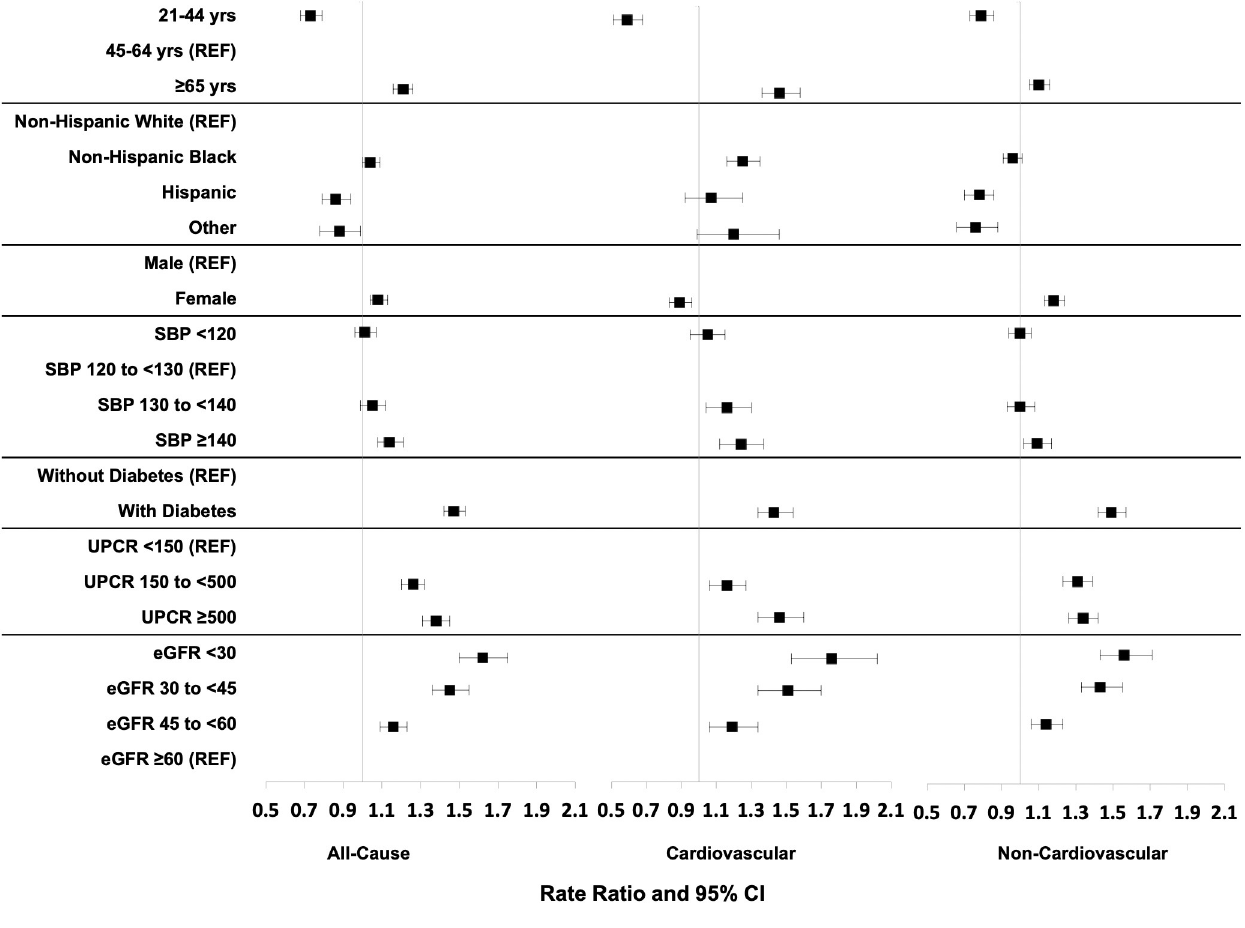
Fig 2. Plot of adjusted all-cause, cardiovascular, and non-cardiovascular hospitalization rate ratios. Error bars indicate 95% confidence intervals. Models adjusted for age, race, sex, clinical center, education, SBP, diabetes, UPCR, and CRIC baseline eGFR. CRIC, Chronic Renal Insufficiency Cohort; eGFR, estimated glomerular filtration rate; SBP, systolic blood pressure; UPCR, urine protein-to-creatinine ratio.